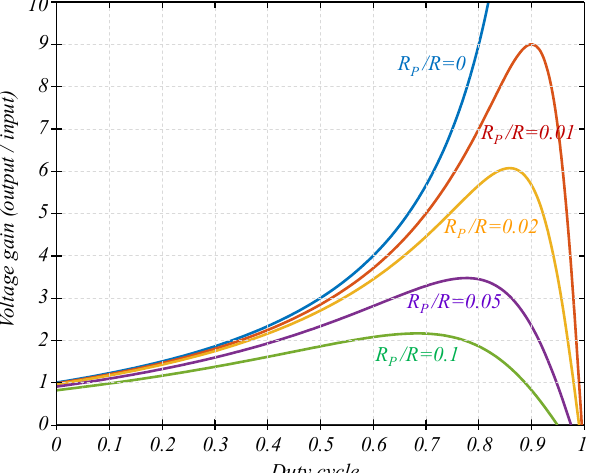
Figure 9. Voltage gains as a function of the duty cycle considering conduction losses in the parasitic resistance of elements.